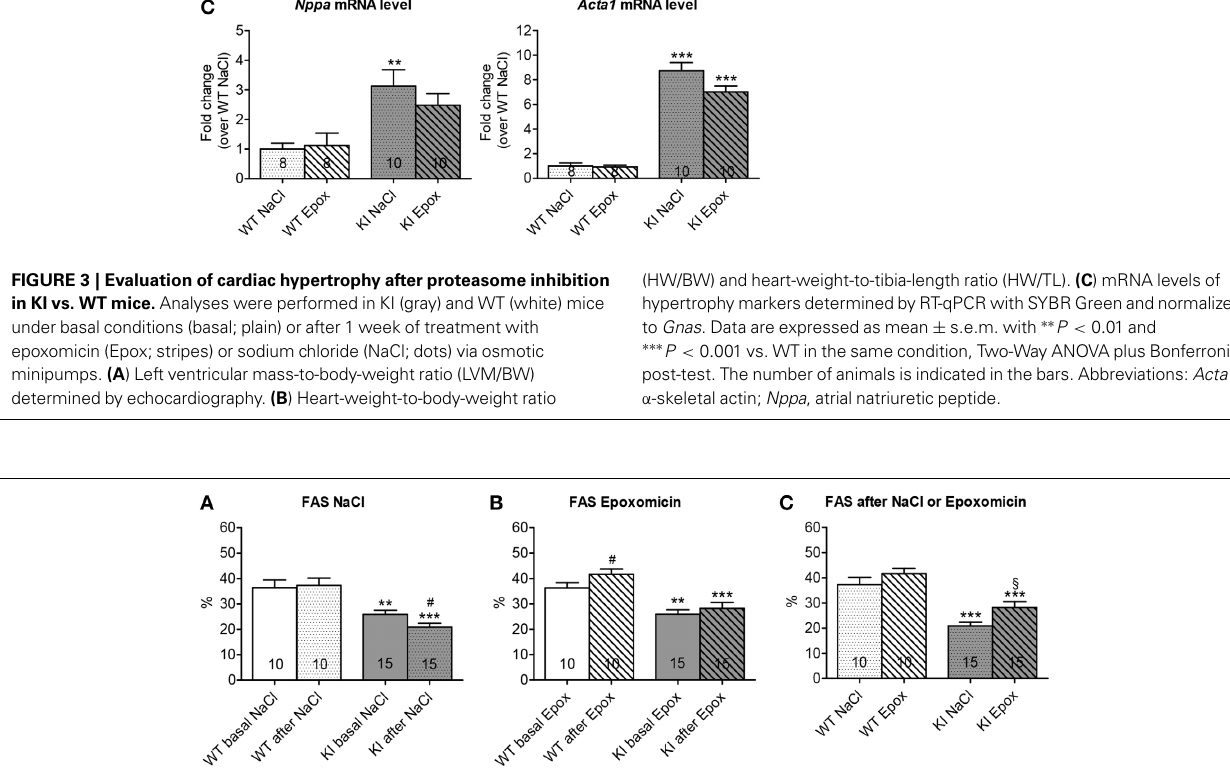
Data are expressed as mean ± s.e.m. with ∗∗ P < 0 . 01 and ∗∗∗ P < 0 . 001 vs. WT in the same condition, Two-Way ANOVA plus Bonferroni’s post-test, # P < 0 . 05 vs. corresponding basal, paired Student‘s t -test, and § P < 0 . 05 vs. KI NaCl, unpaired Student‘s t -test. The number of animals is indicated in the